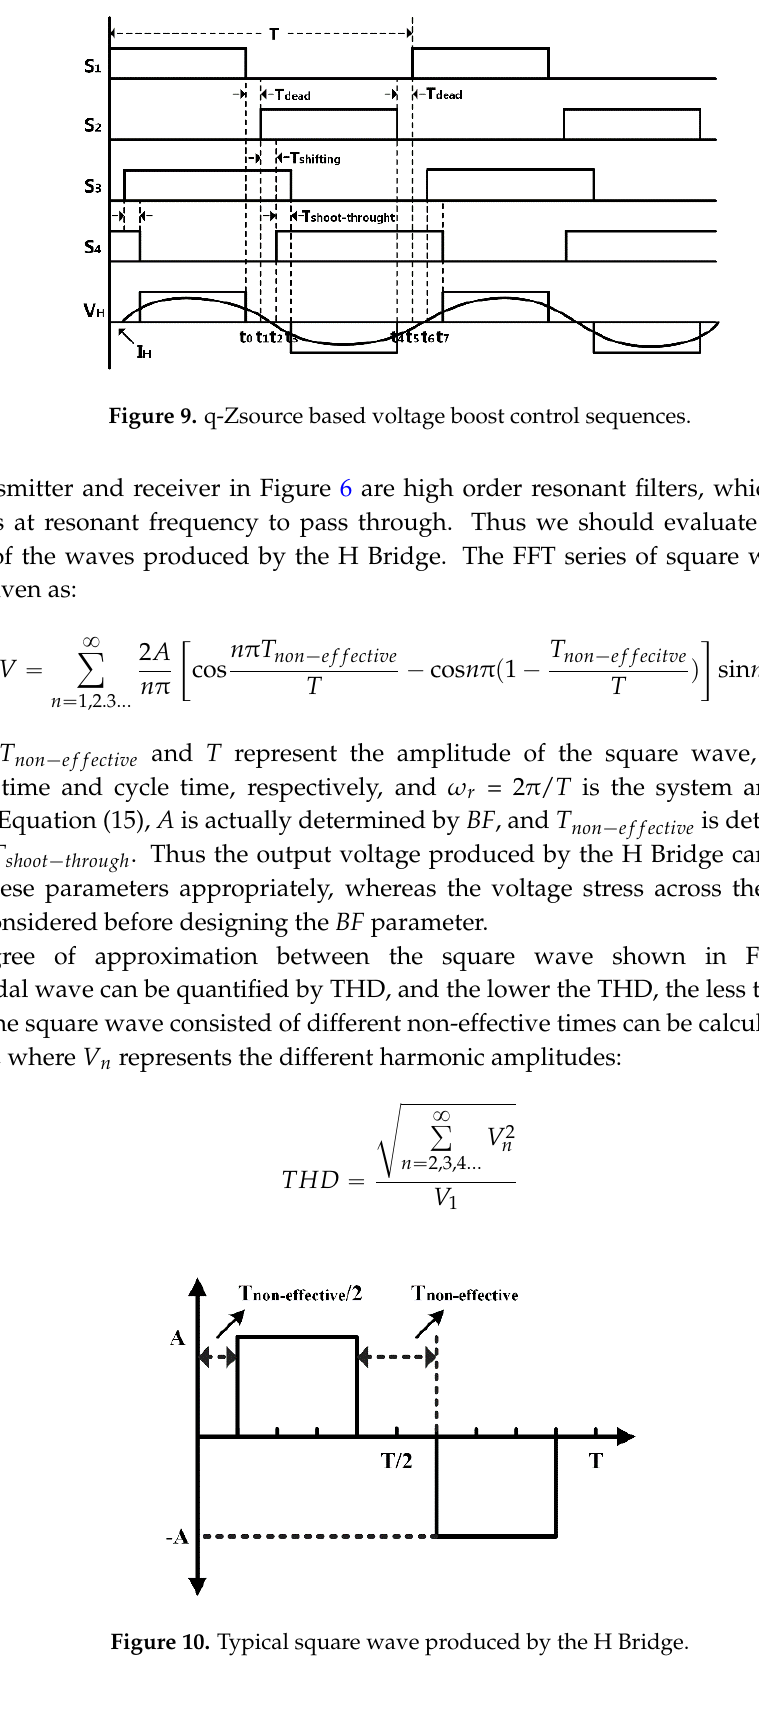
( b ) Figure 11. THDs of square waves with different non ‐ effective times at 50 kHz ( a ) and 80 kHz ( b ). 4. Experiments A prototype was implemented to validate our research results, as shown in Figure 12, and the magnetic coils are designed based on the nested three ‐ layer optimization method, which will be discussed in our other papers. The prototype is fabricated according to the schematic shown in Figure 6, where the power source adopts a 62100H ‐ 600 high ‐ voltage DC power supply (Chroma, Taoyuan, Taiwan), the H Bridge employs four SPW47N60C3 MOSFETs (Infineon, Neubiberg, Germany), the resonant capacitors adopt B32672L thin ‐ film series (TDK ‐ EPCOS, Tokyo, Japan) ,the rectifier consists of four IDW30E65D1 fast recovery diodes (Infineon, Neubiberg, Germany) and the battery pack consists of 24 lead ‐ acid battery units. Figure 13 shows the transfer characteristics of the wireless power transfer system at 20 cm transfer distance, and it is worth mentioning that the q ‐ Zsource does not work, and is only present as a filter. In Figure 13a, the transfer power increases with rising input voltages or battery pack voltages. In practice, the power factor correction (PFC) with 400 V output voltage is employed to enhance AC power quality, and the 300 V battery pack is widely used for many production ‐ ready vehicles, like Toyota Prius, Chevrolet Volt, Mitsubishi i ‐ MiEV as well as Nissan Leaf, thus we define this situation as the system rated operating state. In the rated state, the charging power is 3220 W as shown in Figure 13a, which is a little bigger than 3 kW, since the battery pack voltage increases from 300 V to 309.7 V when the charging current (RMS value is 10.4 A as shown in Figure 14) flows through 0